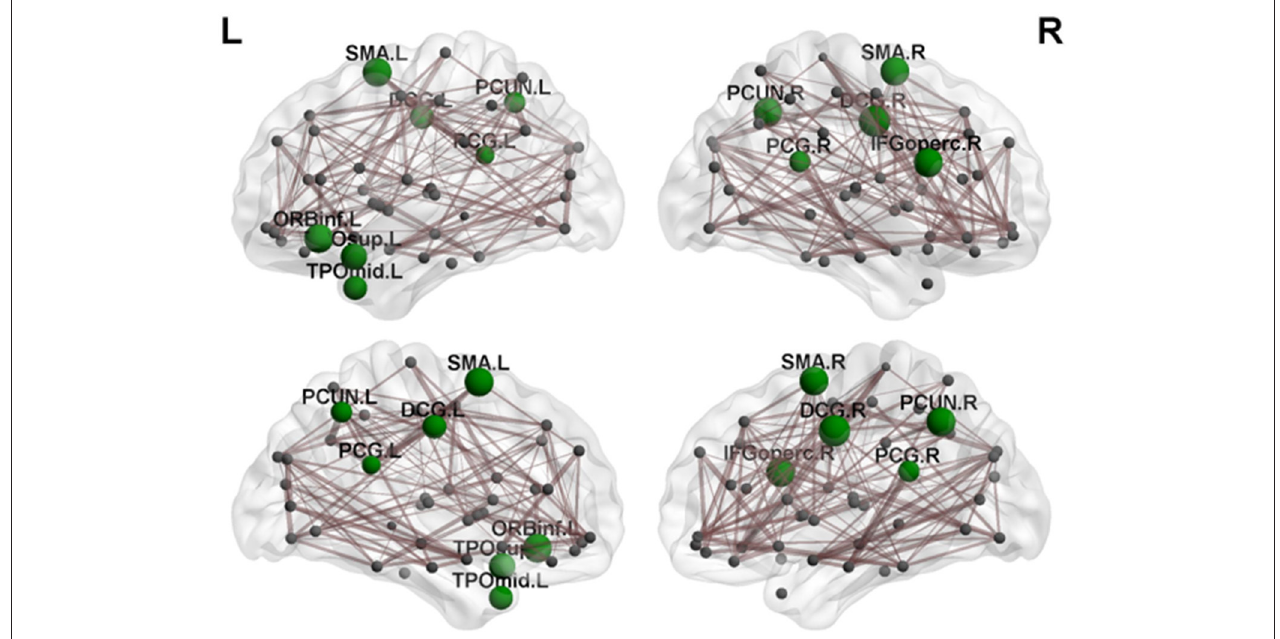
FIGURE 4 | By comparing nodal efficiency between the cerebellar infarction and control group, 12 brain regions with significant differences ( P < 0.05, false discovery rate corrected) between the two groups are shown in green. Node sizes represent the significance of between-group differences in regional nodal efficiency. For the abbreviations of the regions, please see Table 3